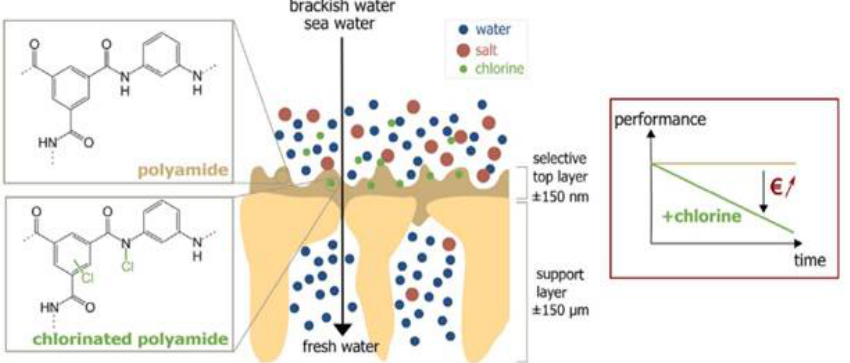
Figure 7. Schematic diagram of the chlorine erosion of PA film and the performance degradation caused by attack [68].